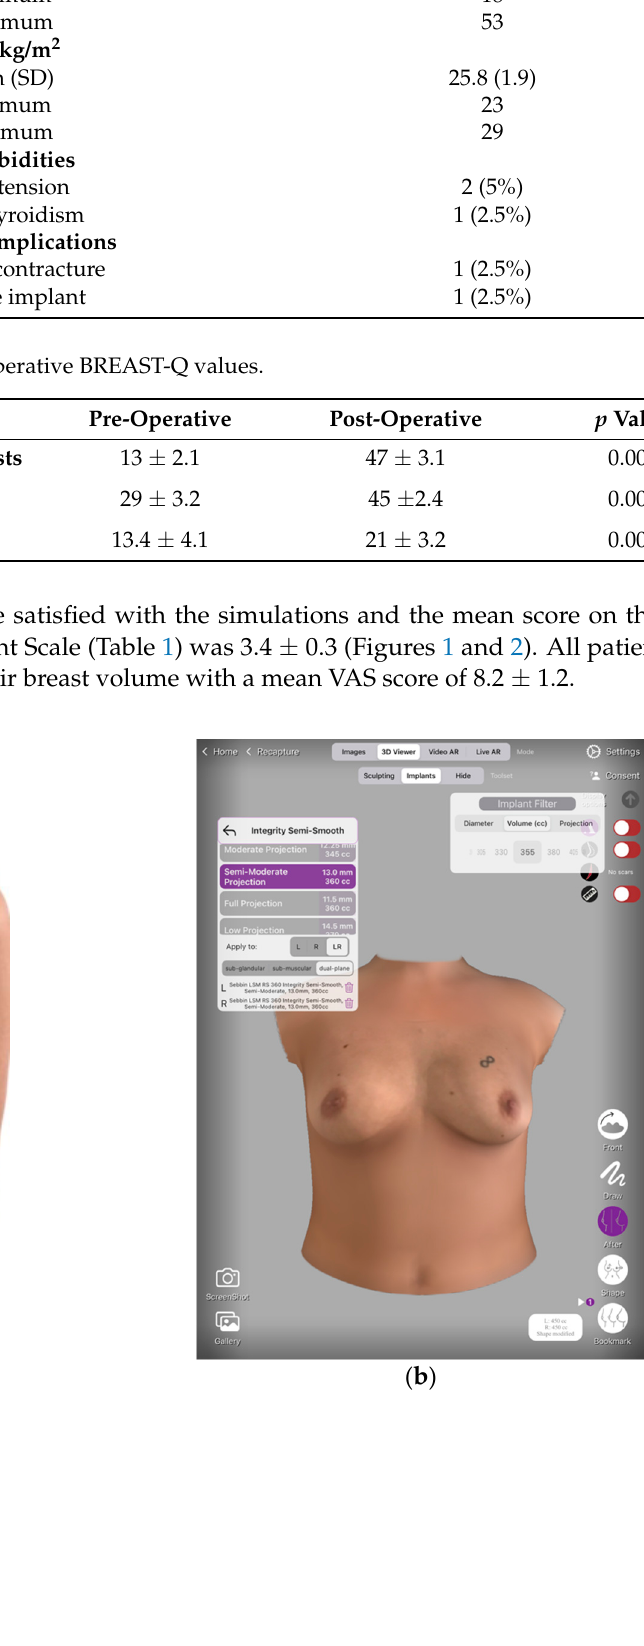
Table 2. Study data.